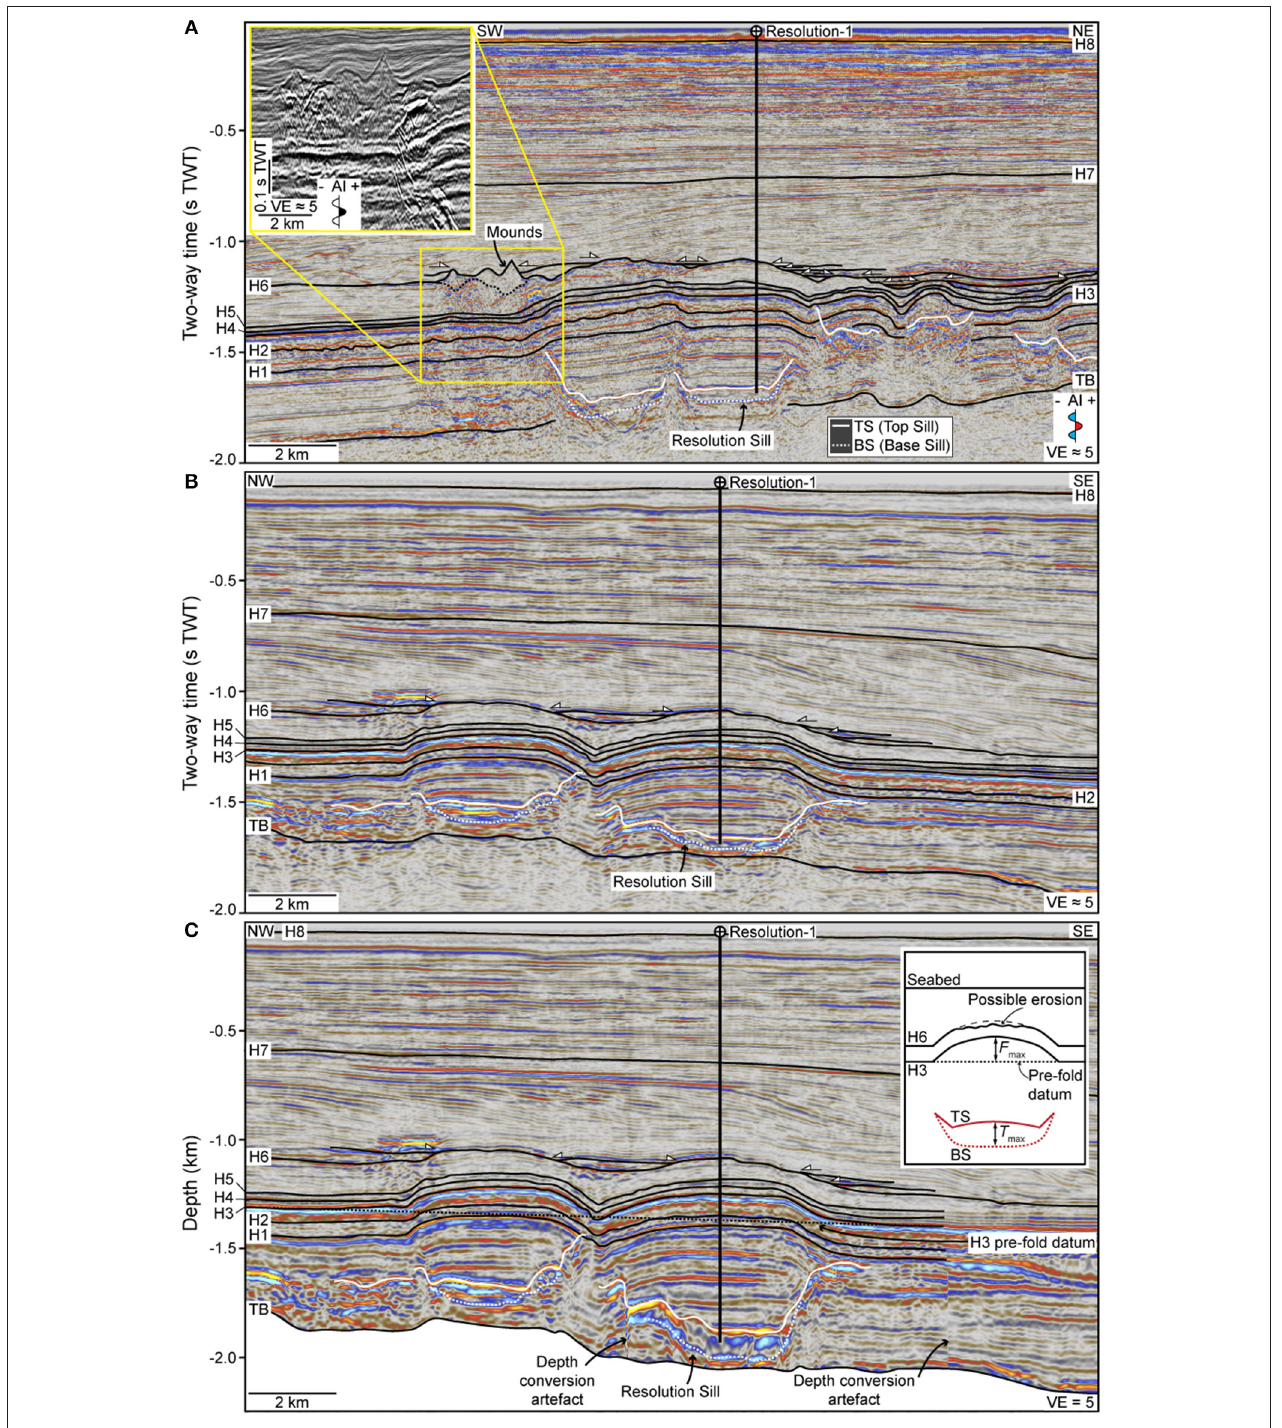
FIGURE 5 | (A,B) Interpreted, time-migrated seismic sections imaging the Resolution Sill and neighboring intrusions. Mapped stratigraphic horizons are marked and white-filled arrows highlight onlap onto H6. Inset in (A) shows an uninterpreted, zoomed-in view of the mounded structures. AI, acoustic impedance and VE, vertical exaggeration. See Figure 2B for location of the seismic lines. Uninterpreted sections provided in Supplementary Figure 1 . (C) Depth-converted version of the seismic section shown in (B) . Inset schematically shows how erosion may modify the top of the fold and how F max and T max were measured.